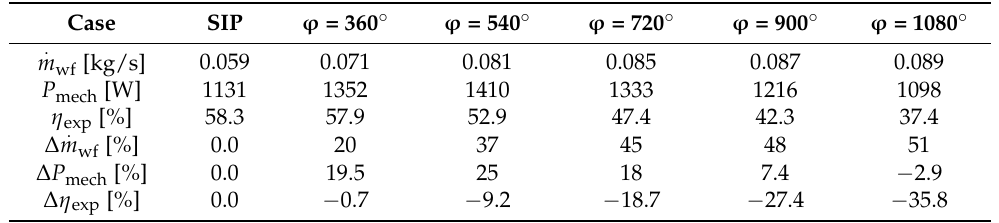
Table 4. Comparison between the SIP and DIP scroll